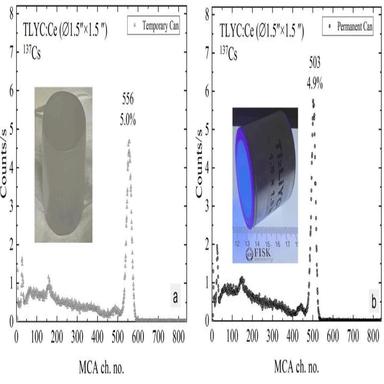
(a) 137Cs spectrum collected with a ∅1.5″ × 1.5″ TLYC sample encapsulated in a temporary can. (b) 137Cs spectrum collected with the same ∅1.5″× 1.5″ TLYC sample but encapsulated in a permanently sealed hermetic can.